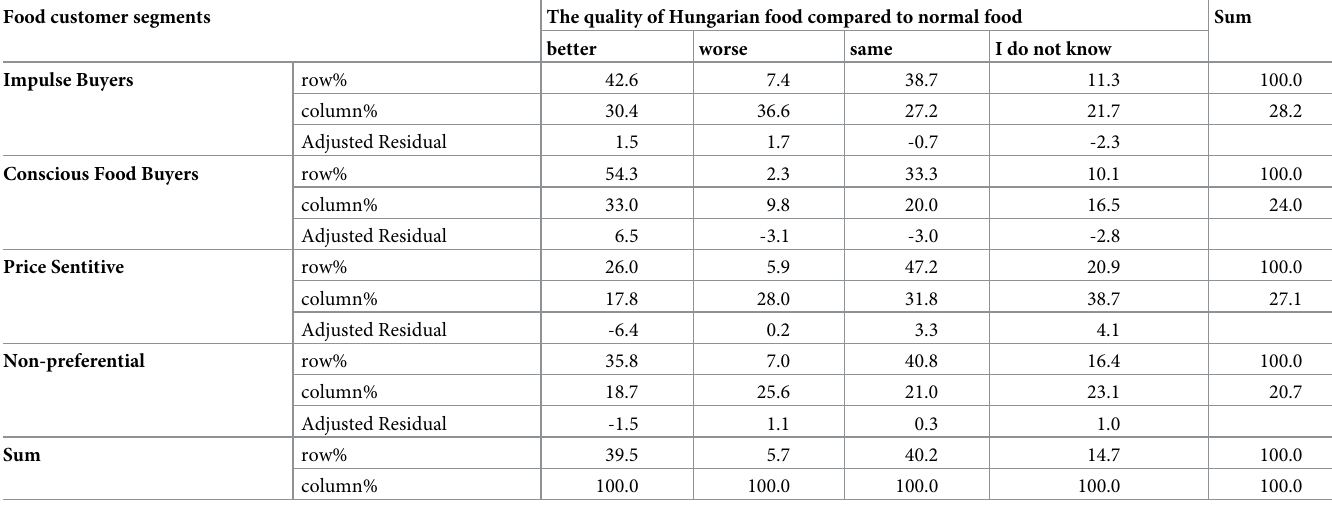
Table 4. Opinions of food customer segments on the quality of Hungarian food. Food customer